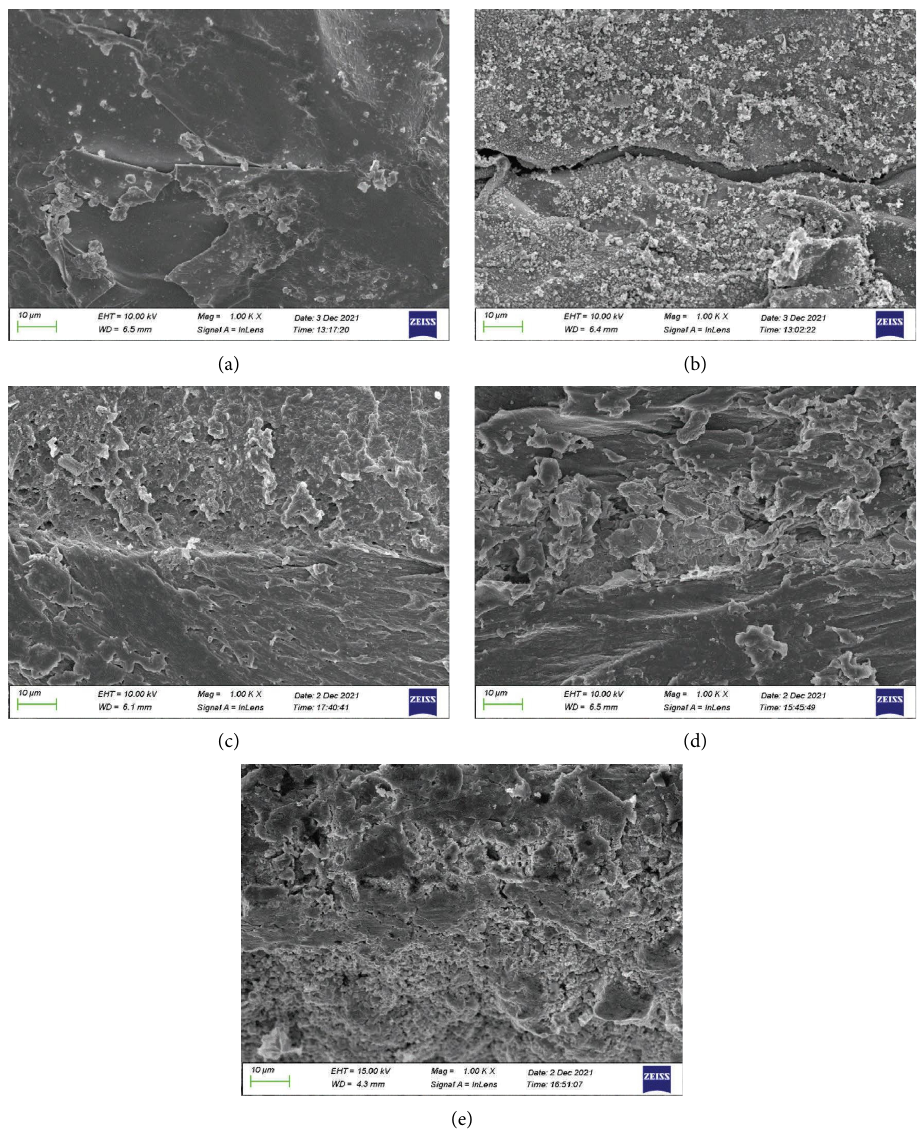
Figure 3: SEM fgure: (a) SEM of common IPMC; (b) SEM of MWCNT-enhanced IPMC; (c) SEM of ordinary porous IPMC; (d) SEM of freeze-dried common IPMC; (e) SEM of freeze-dried MWCNT-reinforced